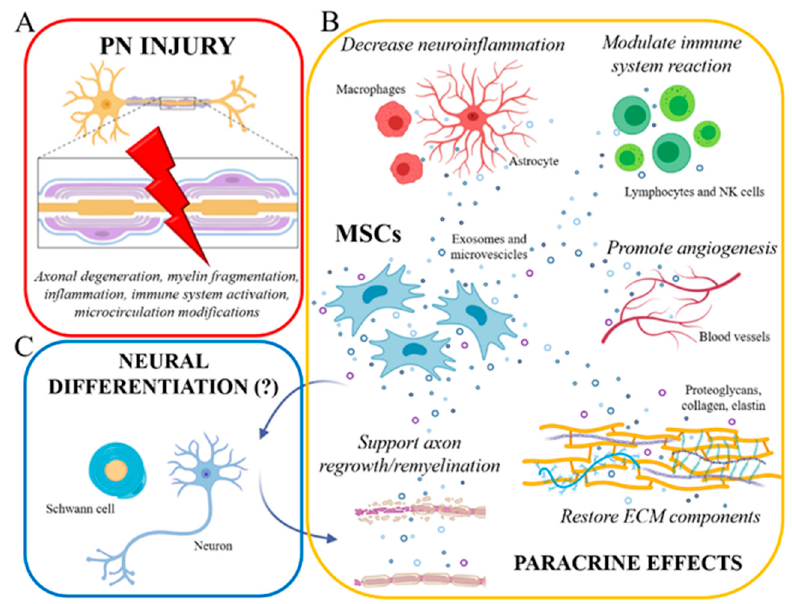
Figure 1. ( A ) Peripheral nerve injury triggers a cascade of cellular/molecular events, including axonal damage, myelin disruption, early inflammatory reactions, immune system activation, and microcirculation modifications. ( B ) Mesenchymal stem cells (MSCs), exerting their prominent paracrine role by exosome/microvesicle secretion, can effectively counteract these events: indeed, MSCs are able to modulate neuroinflammation and immune cell reaction, to promote new blood vessel formation (angiogenesis), to form ECM components, and to sustain axonal regrowth and remyelination. ( C ) Some authors also tried to develop in vitro differentiation protocols to induce neural (Schwann cells and neurons) differentiation of MSCs (eventually able to further support axonal regeneration/remyelination), Nevertheless, the real occurrence of such differentiation is still much debated. Created with BioRender